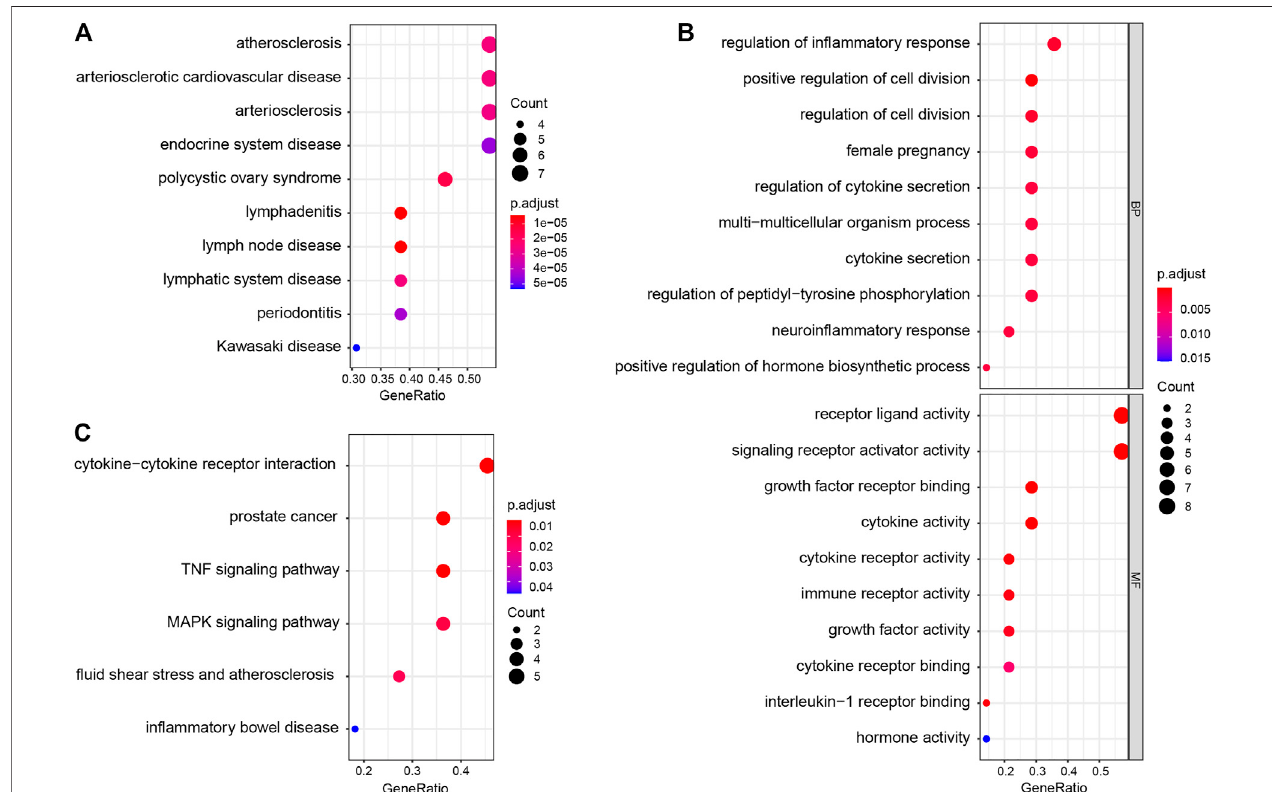
FIGURE 2 | Disease Ontology (DO), Gene Ontology (GO), and Kyoto Encyclopedia of Genes and Genomes (KEGG) enrichment analysis ofimmune-related DEGs. (A) DO enrichment analysis (top 10 according to adjusted p value). (B) GO enrichment analysis; the fi gure represents biological process and molecular function (top 10 according to adjusted p value, respectively). (C) KEGG pathway analysis results of immune-related DEGs.